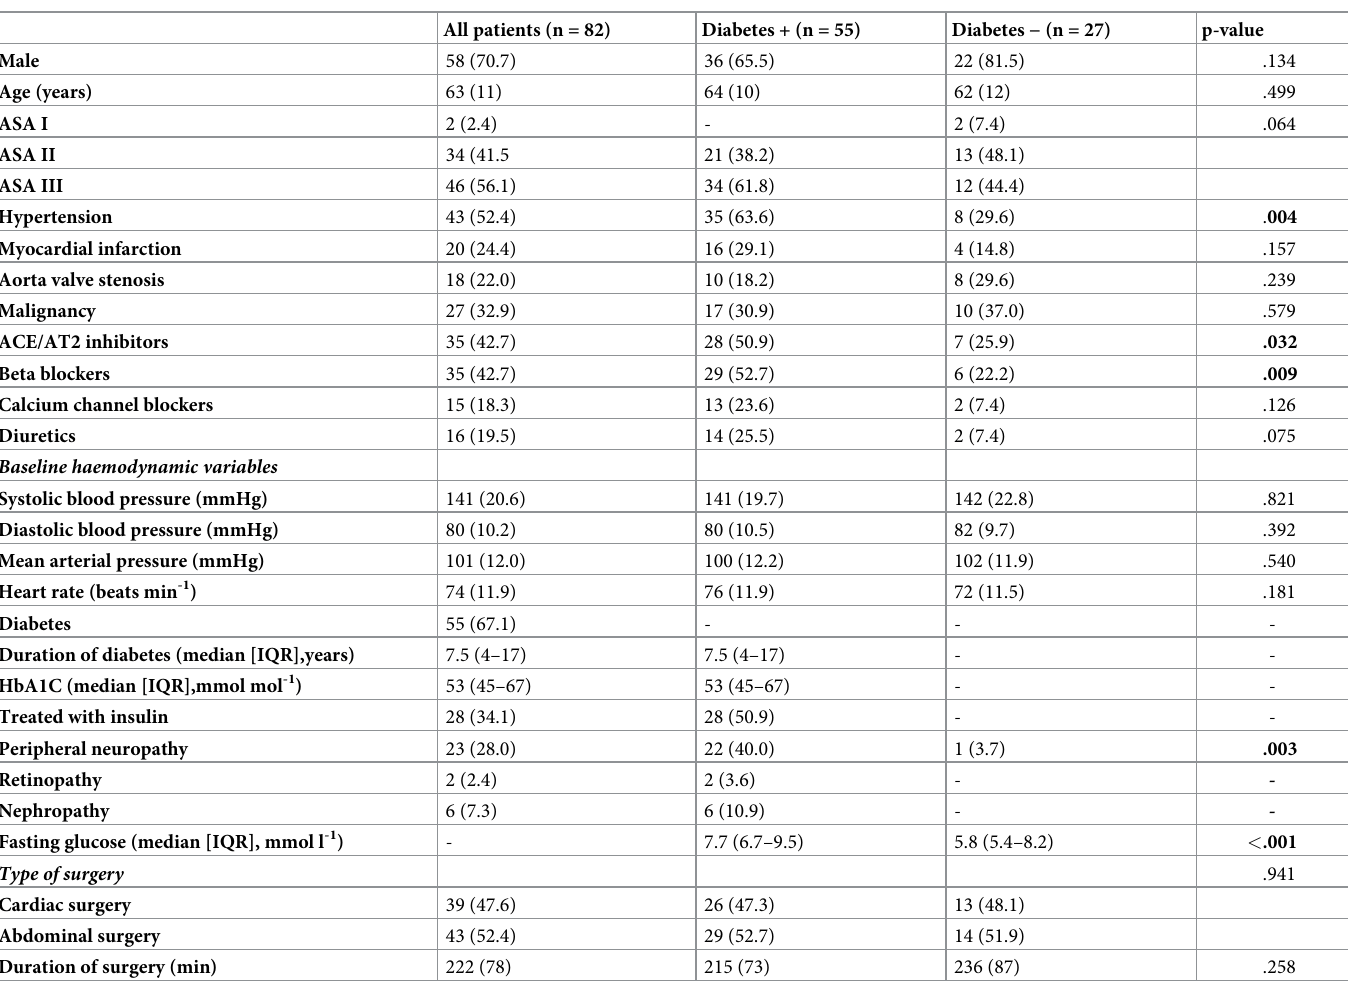
Table 1. Patient